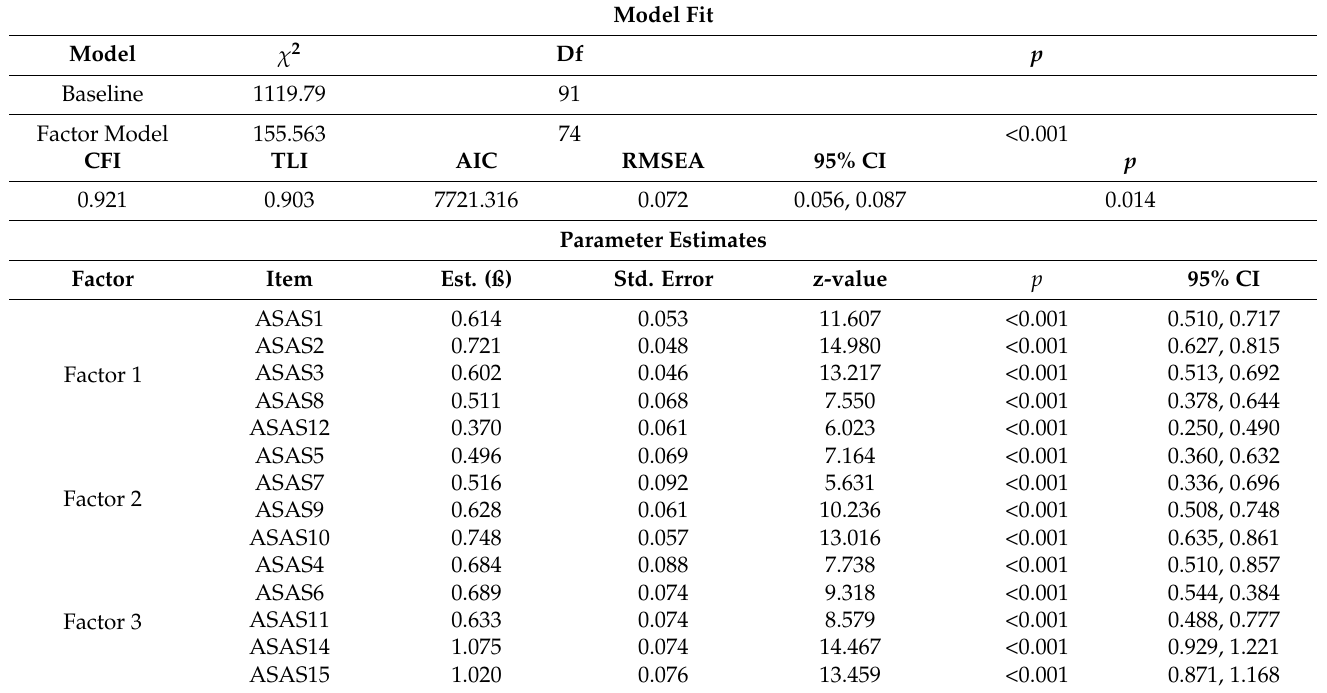
Table 3. Confirmatory factor analysis for the current